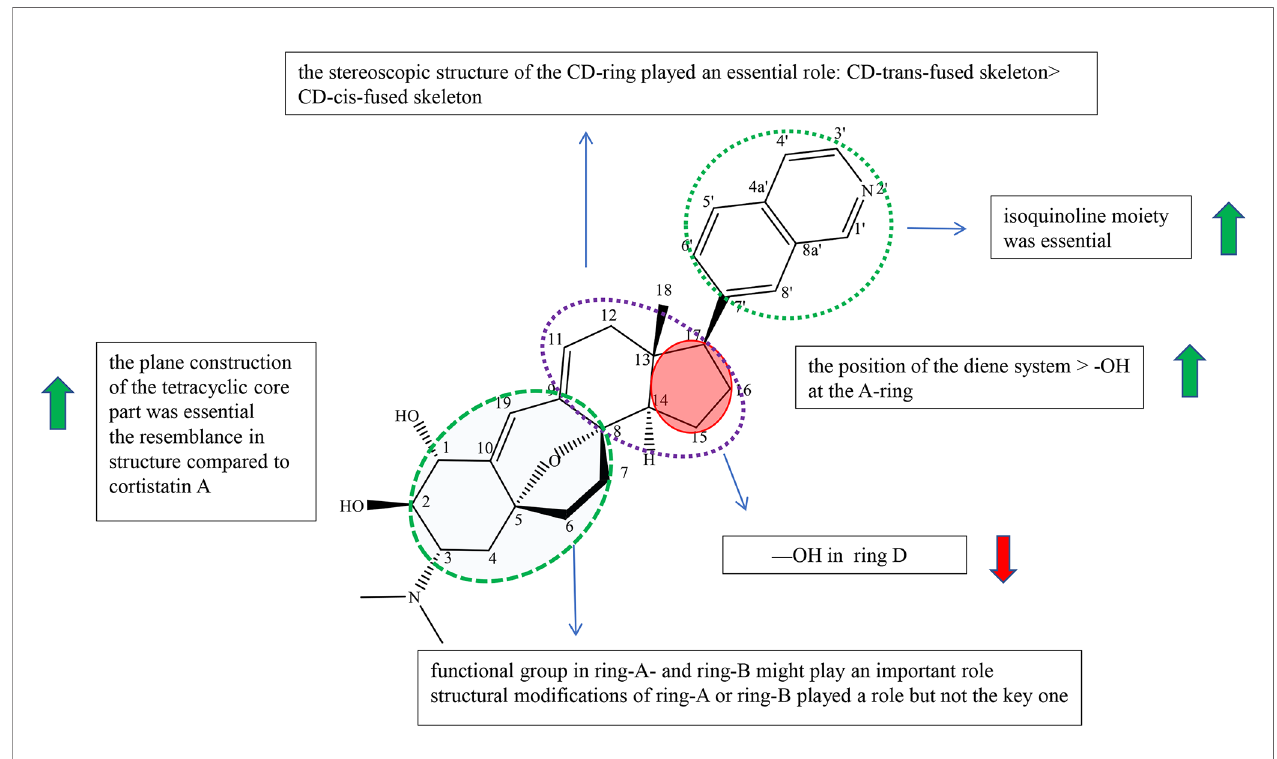
FIGURE 3 | Summary of Structure-activity Relationship of Cyclopregnane